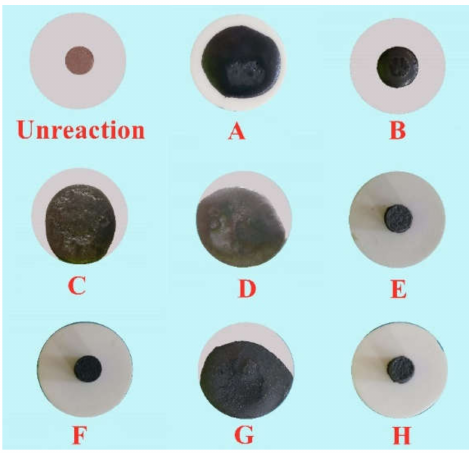
Figure 6. Schematic diagram of liquid phase fluidity of iron ores in various alumina